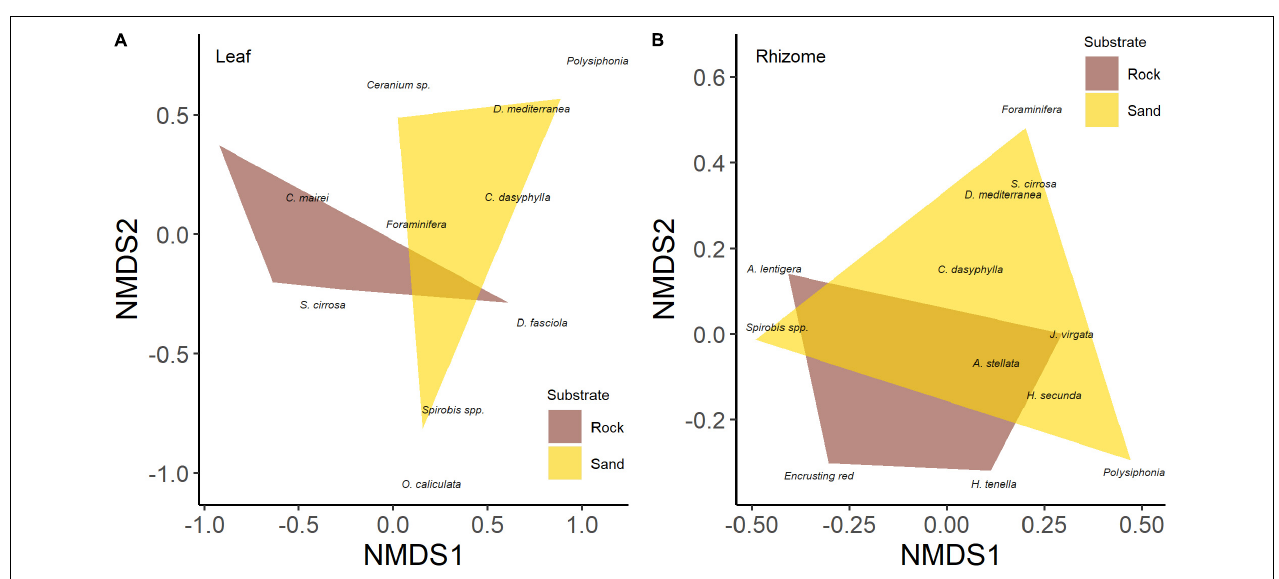
FIGURE 3 | Differences in epiphyte community of leaves (A) and rhizomes (B) of five-year-old seedlings of Posidonia oceanica grown on rock and sand substrate type based on n-MDS